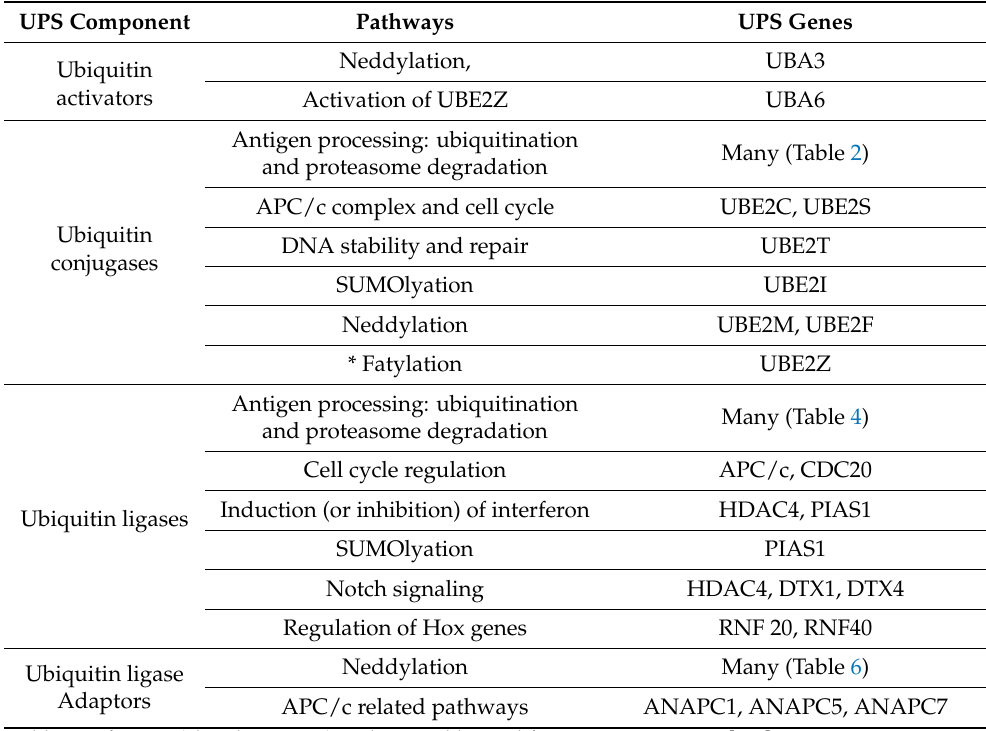
Table 8. Major over-expressed pathways associated with differential expression of UPS genes in subtypes of